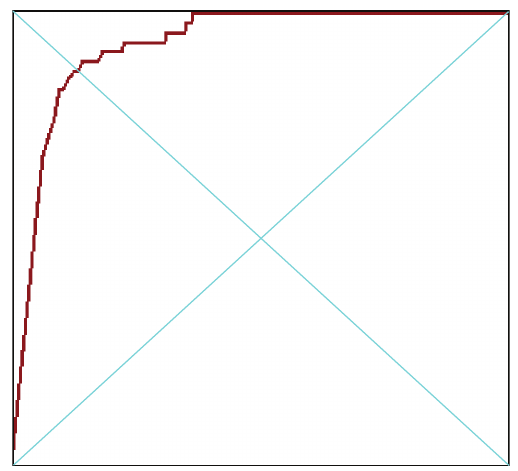
Figure 5: The ROC curve of the single-set S test.